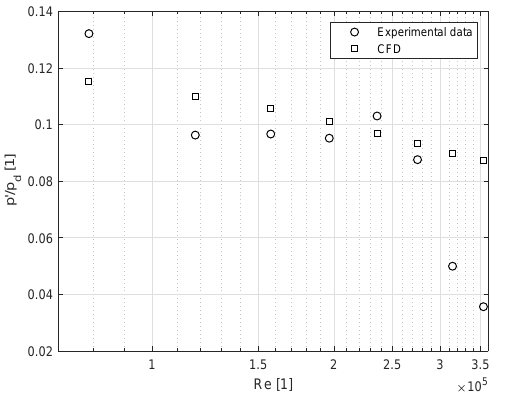
Fig. 10. Relation between Reynolds number and mean static pressure amplitude